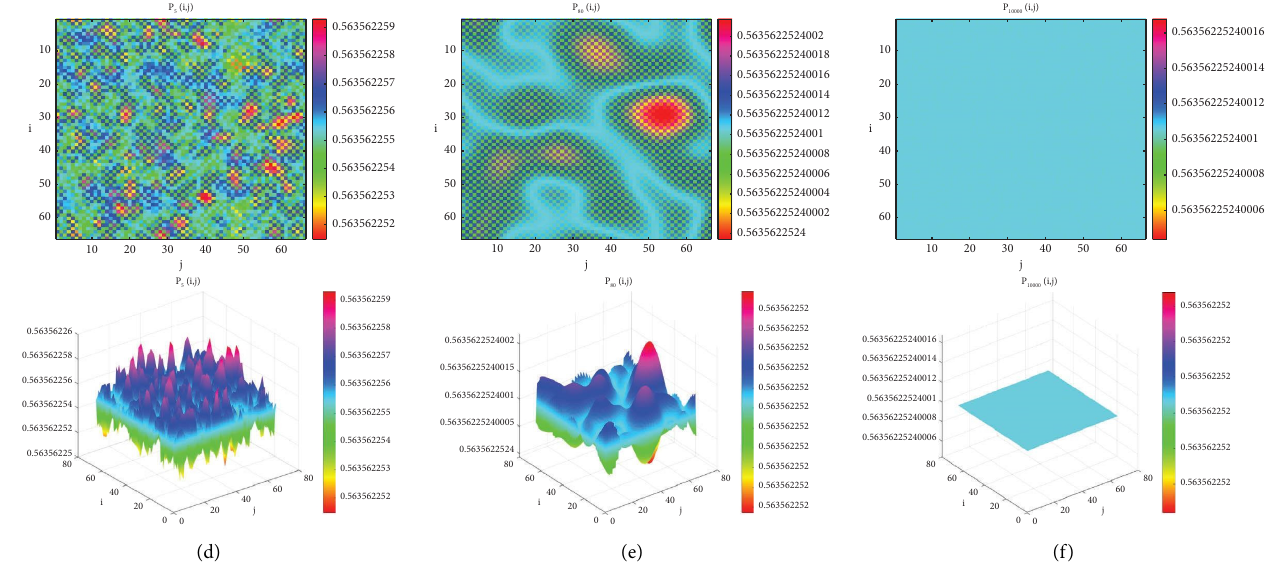
� 0 . 15, ( d , σ ) � ( 0 . 2 , 0 . 75 ) falls in the region I of Figure 7(b), which is consistent with 2 1